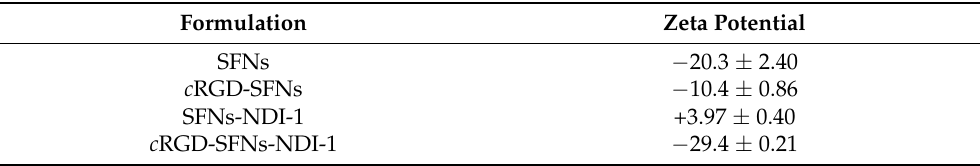
Table 3. Zeta potential of all the nanoparticles prepared. Data are reported in mV as mean value ± standard deviation, n = 3 independent